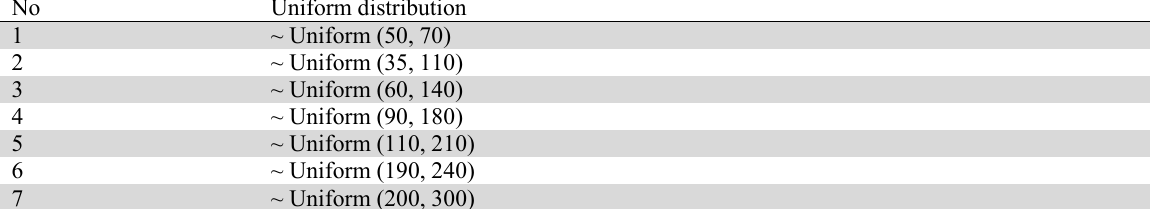
Uniform distribution used in sensitivity analysis of demand for each product